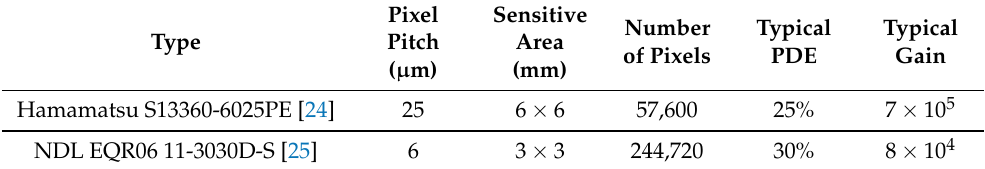
Table 1. Devices under test and their basic parameters.